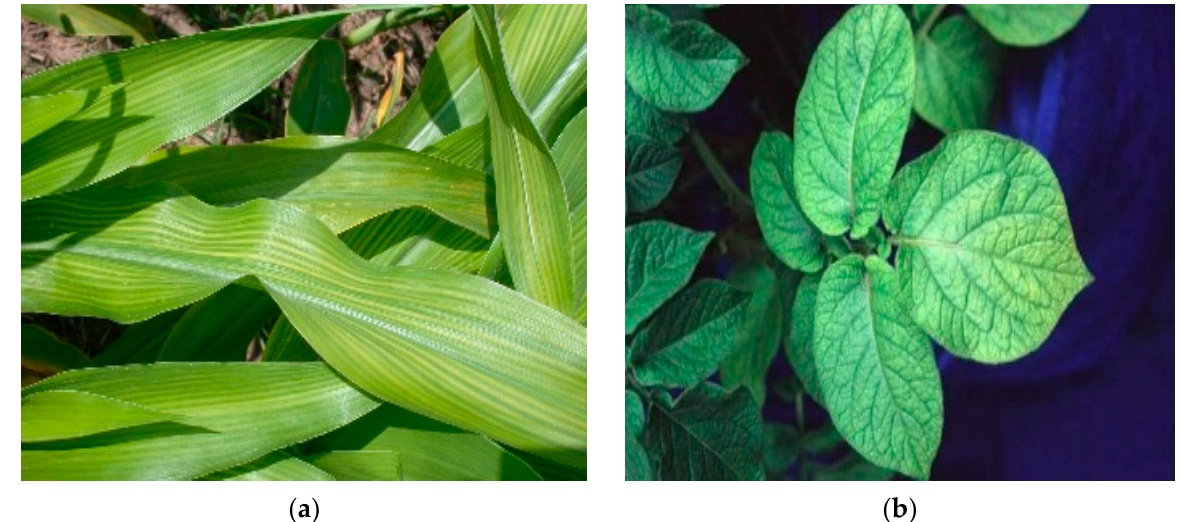
Figure 3. Visual symptoms of sulphur (S) deficiency in selected crop species: ( a ) Maize. S deficiency exhibits itself as interveinal chlorosis; ( b ) Soybean. Plants show pale yellow colour of new leaves at the beginning and gradually the whole plant turns yellow due to severe S deficiency, plants have smaller leaves and shorter internodes. Photo credits: Both photographs shown here are used with permission from Smart Fertilizer UK (https://www.smart-fertilizer.com/ accessed on 15 September 2020) and due credit is therefore hereby accorded. The photographs were sourced from their website: https://www.smart-fertilizer.com/articles/sulfur/ (accessed on 15 September 2020).